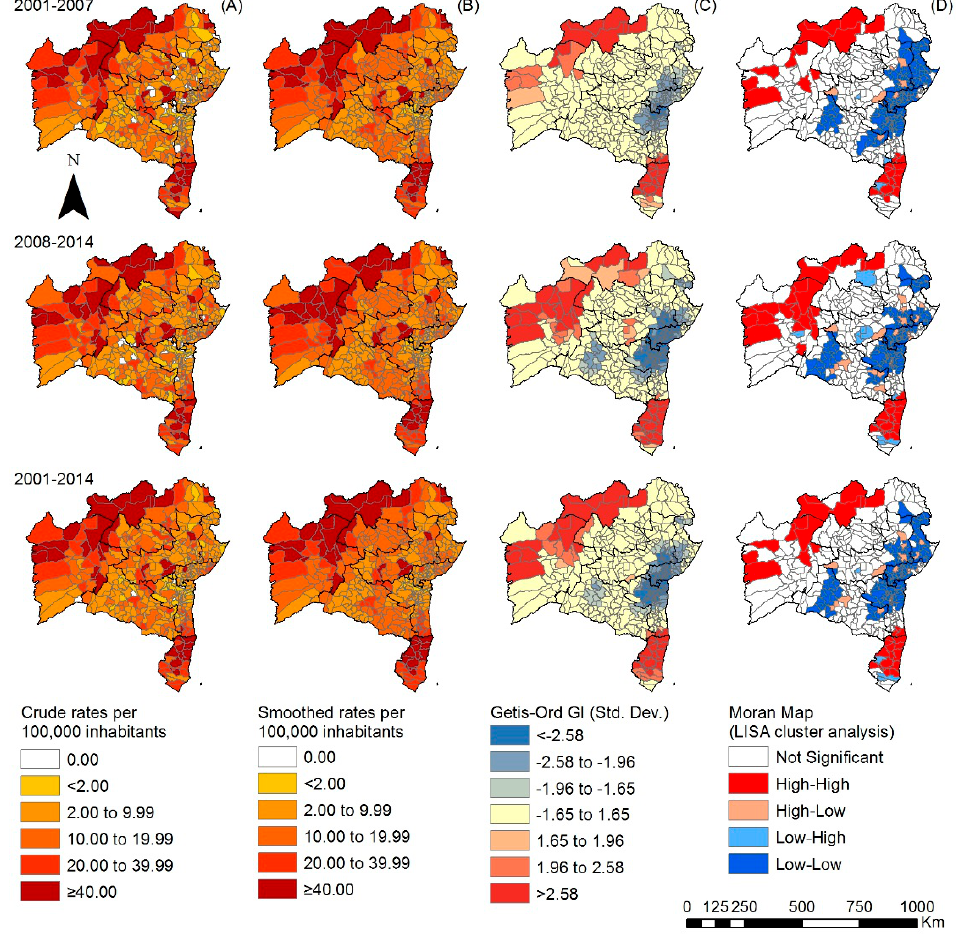
Figure 2. Spatiotemporal distribution of the overall new case detection rate of leprosy by municipality, Bahia state, 2001–2014: ( A ) crude detection rates (per 100,000 inhabitants); ( B ) Bayesian-smoothed detection rate (per 100,000 inhabitants); ( C ) hot-spot analysis (Getis-Ord Gi*) and ( D ) LISA cluster analysis (Moran Map).